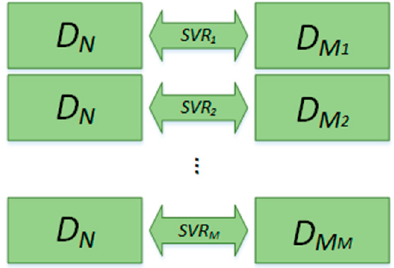
Figure 3. Principle of LargeVis training-based SVR.